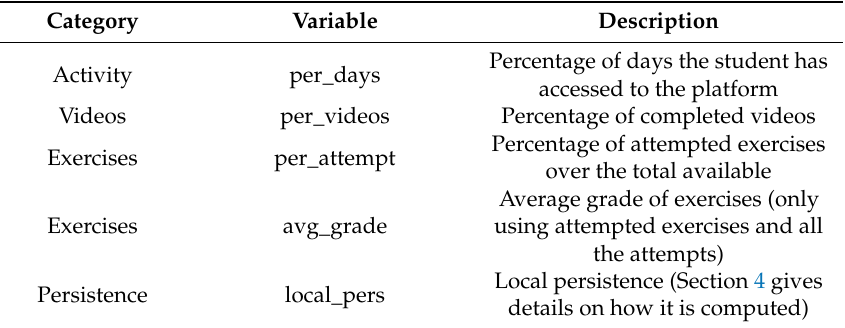
Table 1. Features used in the predictive